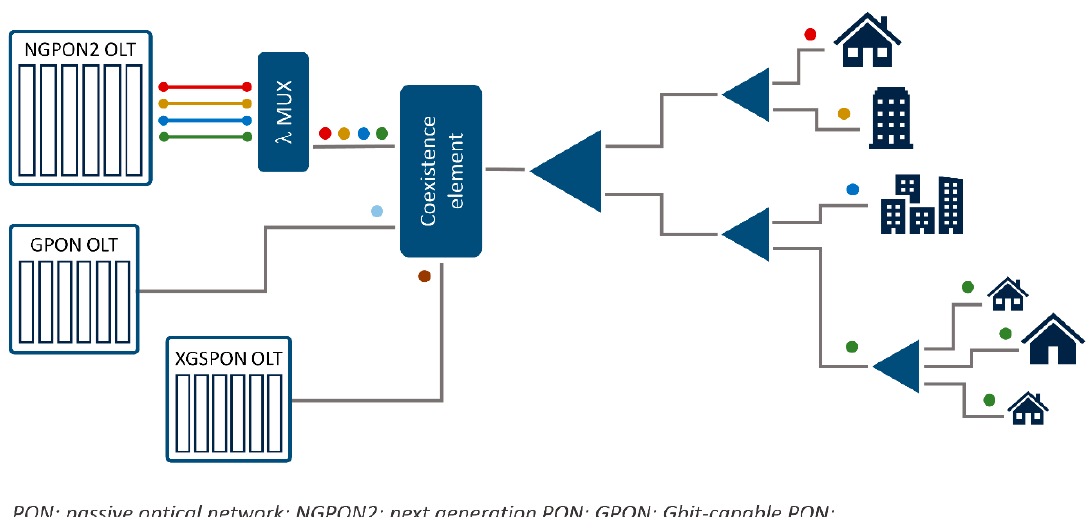
Figure 3. Diagram describing a PON architecture with three coexisting technologies.